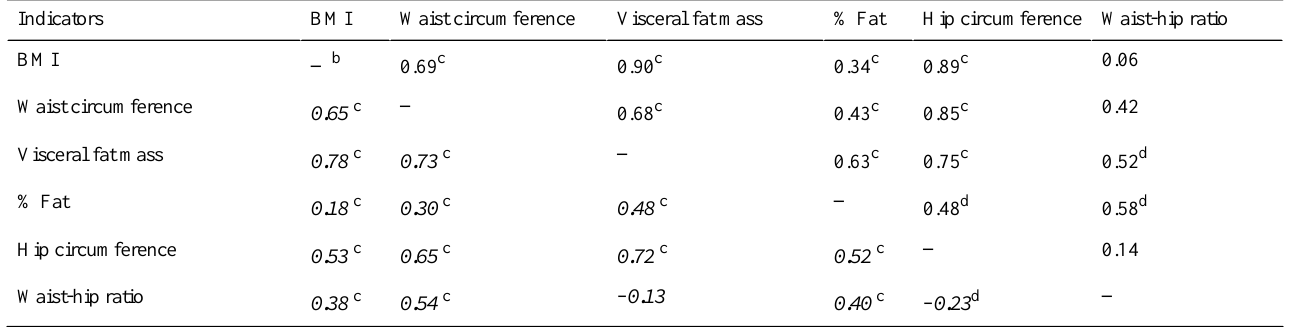
Table 4. Matrix of correlation of the measurements of the anthropometric indicators a of